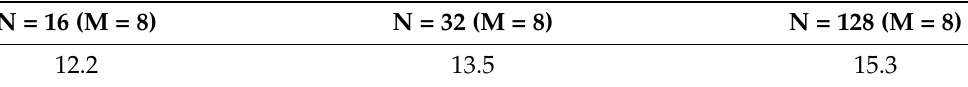
Table 3. Mean of Monte Carlo simulations’ position RMSE, using magnetic anomaly map with different group size and same subgroup size (unit: